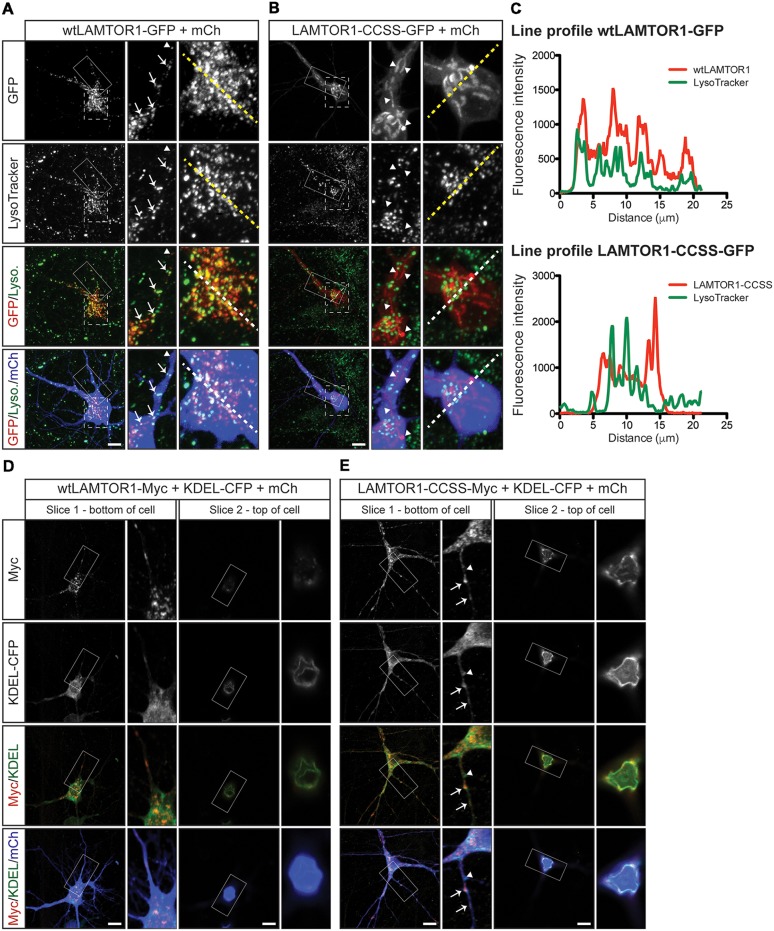
Palmitoylated wtLAMTOR1 localizes to lysosomes whereas LAMTOR1-CCSS partially localizes to endoplasmic reticulum (ER) membranes. (A) Hippocampal neurons were transfected to express wtLAMTOR1-GFP and morphology marker mCherry (mCh) prior to incubation with LysoTracker dye and subsequent live imaging. First
column: images of GFP and LysoTracker signals and merged images of GFP/LysoTracker (Lyso.) and GFP/Lyso./mCh signals. Second column: magnified views of the solid boxed area of first column images. Arrows indicate LAMTOR1-GFP positive vesicles that are also LysoTracker positive Arrowheads indicate LAMTOR1-GFP puncta that are LysoTracker negative. Third column: magnified views of the dotted boxed area of first column images. (B) As in A except that neurons were transfected with LAMTOR1-CCSS-GFP. (C) Graphs of the fluorescent intensity profiles of wt (top) and CCSS (bottom) LAMTOR-GFP and LysoTracker along the dotted lines indicated in the third columns of A,B, respectively. wt-LAMTOR1 signal closely matches the profile of LysoTracker signal while LAMTOR1-CCSS signal does not. (D)
First column: single slice confocal images from a region close to the bottom of the cell of a hippocampal neuron transfected to express wtLAMTOR1-Myc, the ER marker KDEL-CFP (detected using anti-GFP antibody), and mCh, and merged images of Myc/KDEL-CFP (KDEL) and Myc/KDEL/mCh signals. Second column: magnified views of the boxed area of first column images. Third and fourth columns: as the first and second columns, respectively, except images show a single confocal slice from a region close to the top of the cell. (E) As in D except that neurons were transfected to express LAMTOR1-CCSS-Myc. Arrows indicate LAMTOR1-CCSS-Myc tubules that are positive for KDEL-CFP, arrowhead indicates LAMTOR1-CCSS-Myc KDEL-CFP negative tubule. Scale bar indicates 10 μm.